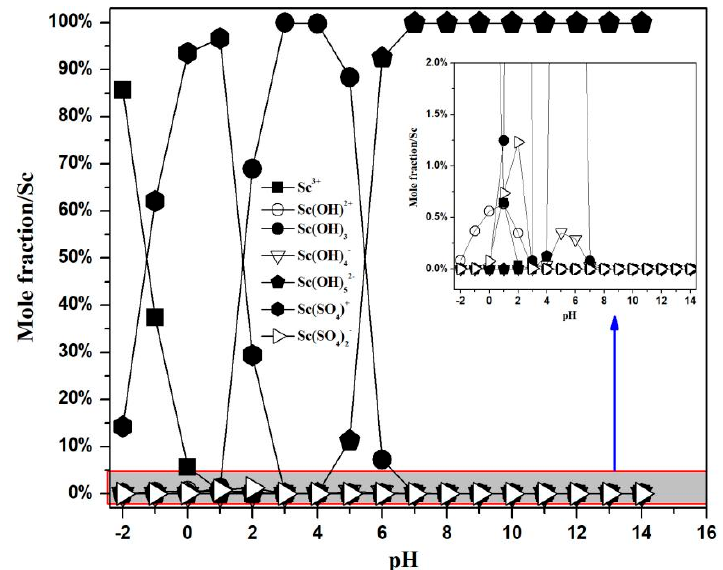
Figure 1. Mole fraction diagram of ions containing scandium in the Sc-S-H 2 O system at 298 K with various pH values ([Sc 3+ ] = 0.001 M and [S 6+ ] = 4 M).